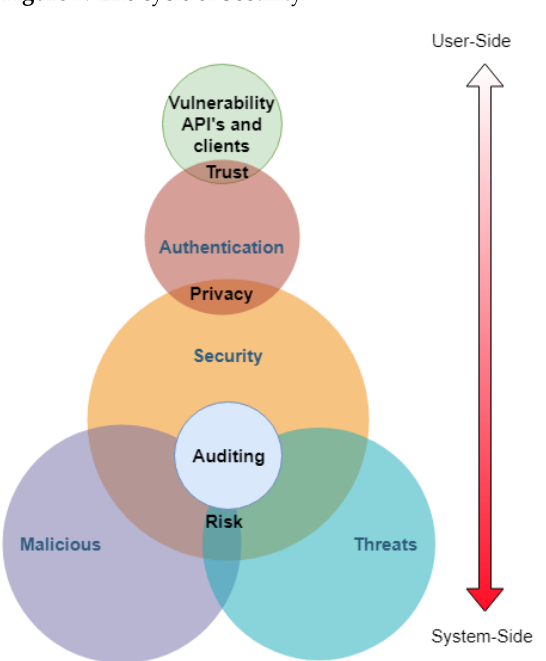
Figure 7. Life cycle of Security.